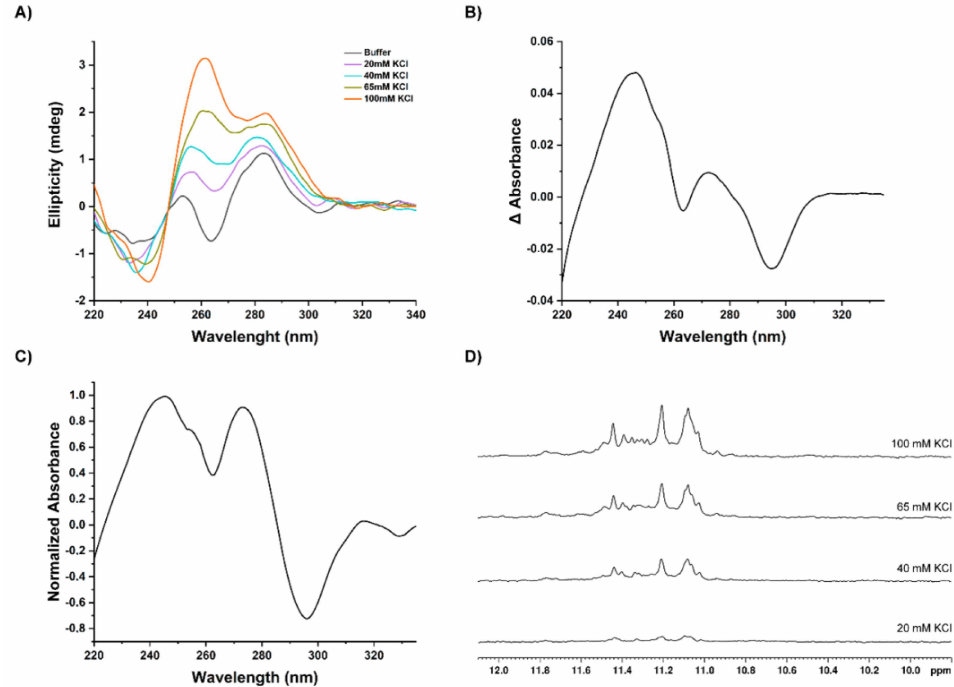
Figure 2. Evaluation of G4 formation using distinct spectroscopic techniques. ( A ) CD spectra of AT11-L2 (10 µ M) in 10 mM of lithium cacodylate buffer with increasing concentrations of KCl in the range of 220–340 nm. ( B ) IDS spectrum resultant from the difference of UV spectra in the presence and absence of KCl. ( C ) TDS spectrum of AT11-L2 in lithium cacodylate containing 100 mM of KCl, obtained by subtracting the spectrum in folded and unfolded states and then normalized relative to the maximum absorbance ( D ) Effect of KCl salt on the structure formation of AT11-L2 G4 (50 µ M) was monitored by 1 H NMR spectroscopy recorded in lithium cacodylate supplemented with 10% D 2 O and increased concentrations of KCl (20 to 100 mM). All measurements were performed at 20 ◦